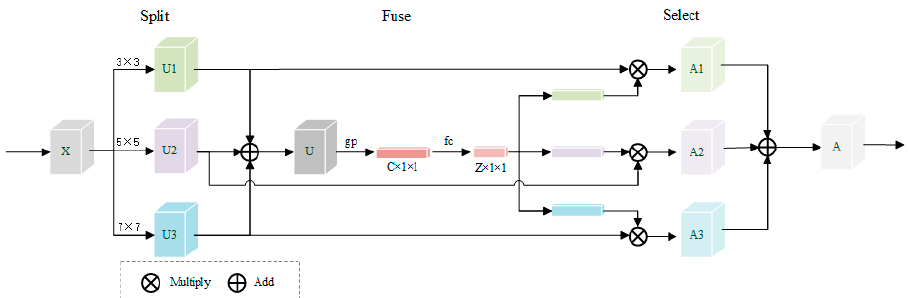
Figure 4. Selective kernel convolution. Adopt three-branch structure. The convolution kernel size of each branch is 3 × 3, 5 × 5, and 7 × 7, respectively.